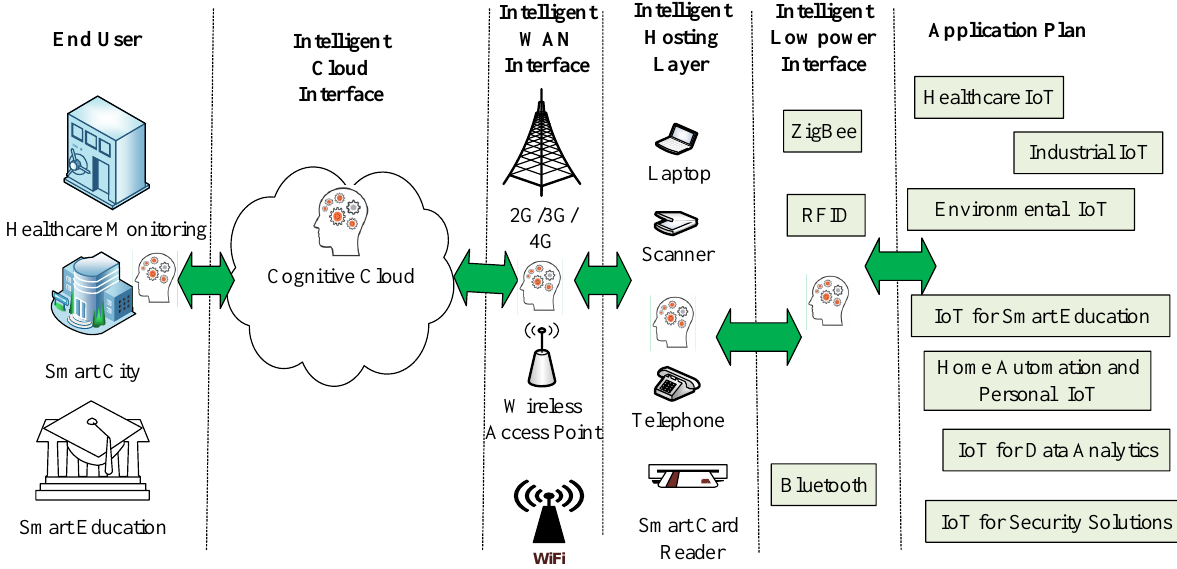
Figure 2. Cognitive IoT network